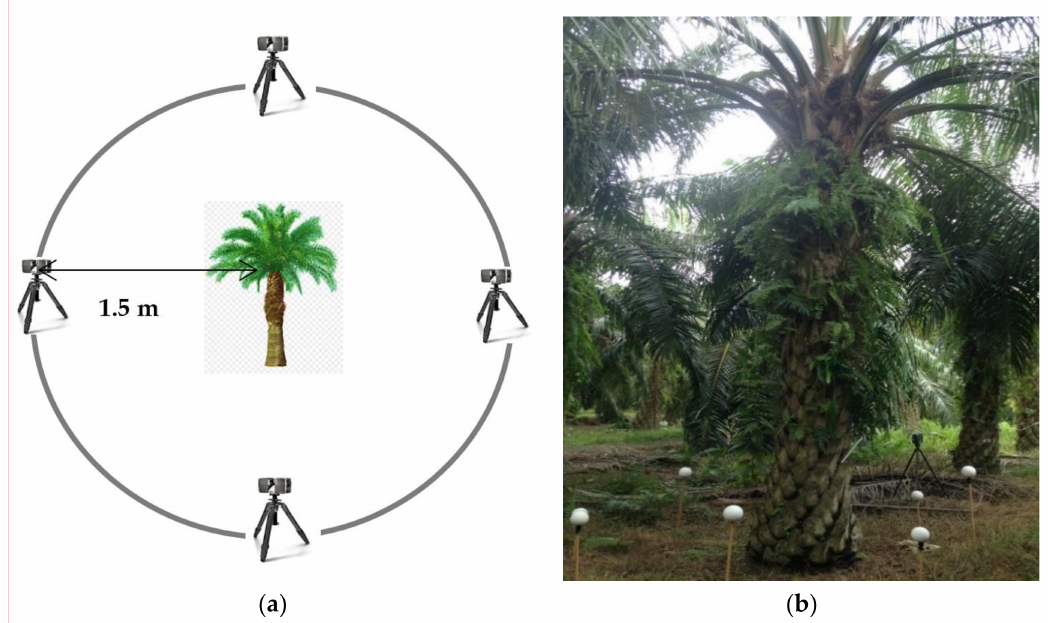
Figure 2. Data collection setup: ( a ) four scan positions around an oil palm tree; ( b ) example of the setup at the site with reference spheres around the